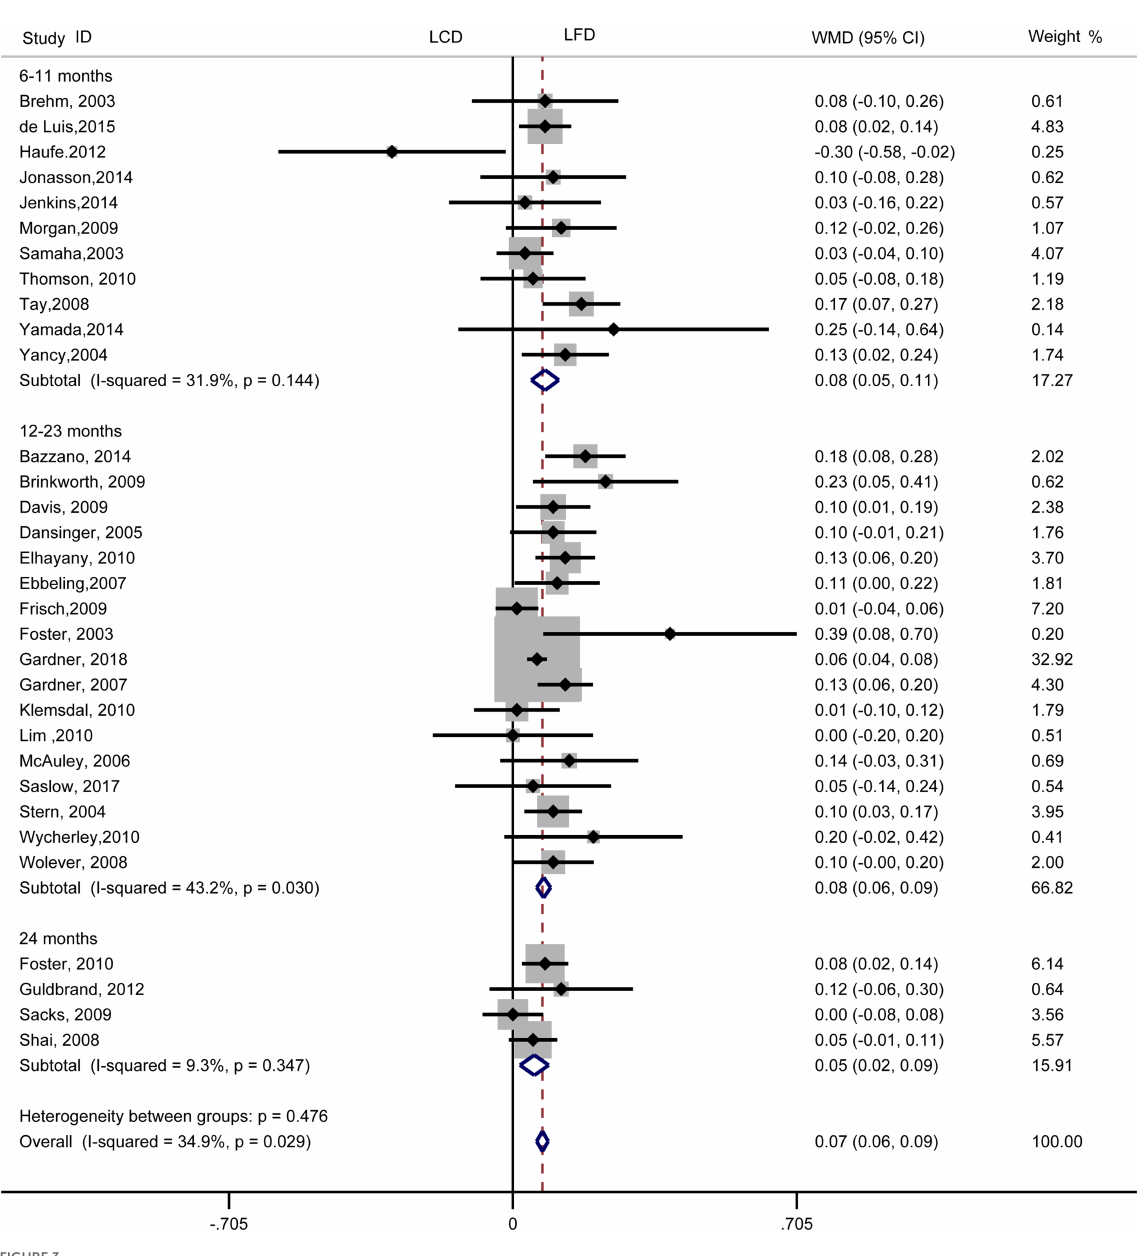
FIGURE3 Forest plots showing weight mean differences (WMD) and 95% CI for HDL-cholesterol of the low-carbohydrate diets (LCD) in comparison with low-fat diets